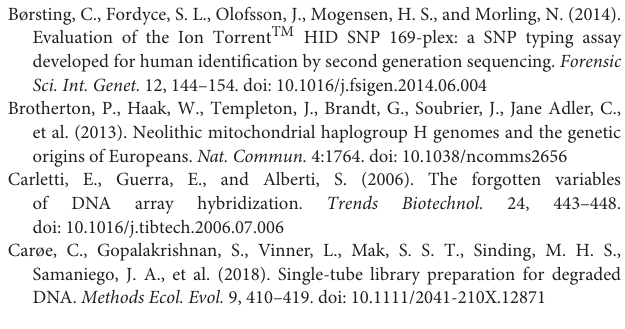
Table S1 | PCR success of the four overlapping HVS-1 control region fragments, endogenous DNA and mtDNA genome coverage after library preparation (Protocol 3) and enrichment, and haplotypes. A PCR was regarded successful where a positive band in gel electrophoresis, however in some cases poor quality sequences were obtained (missing data is in brackets). E2 indicates samples subject to a second round of enrichment . Figure S1 | Exponential decrease in second round enrichment improvement as the % clonality from the first enrichment